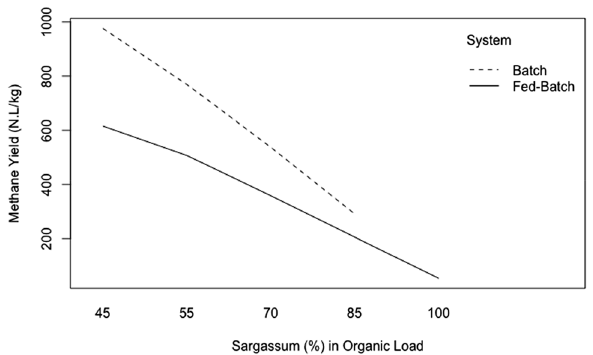
Fig. 4 Interaction plot of the methane yield (N. L CH4/ kg added)